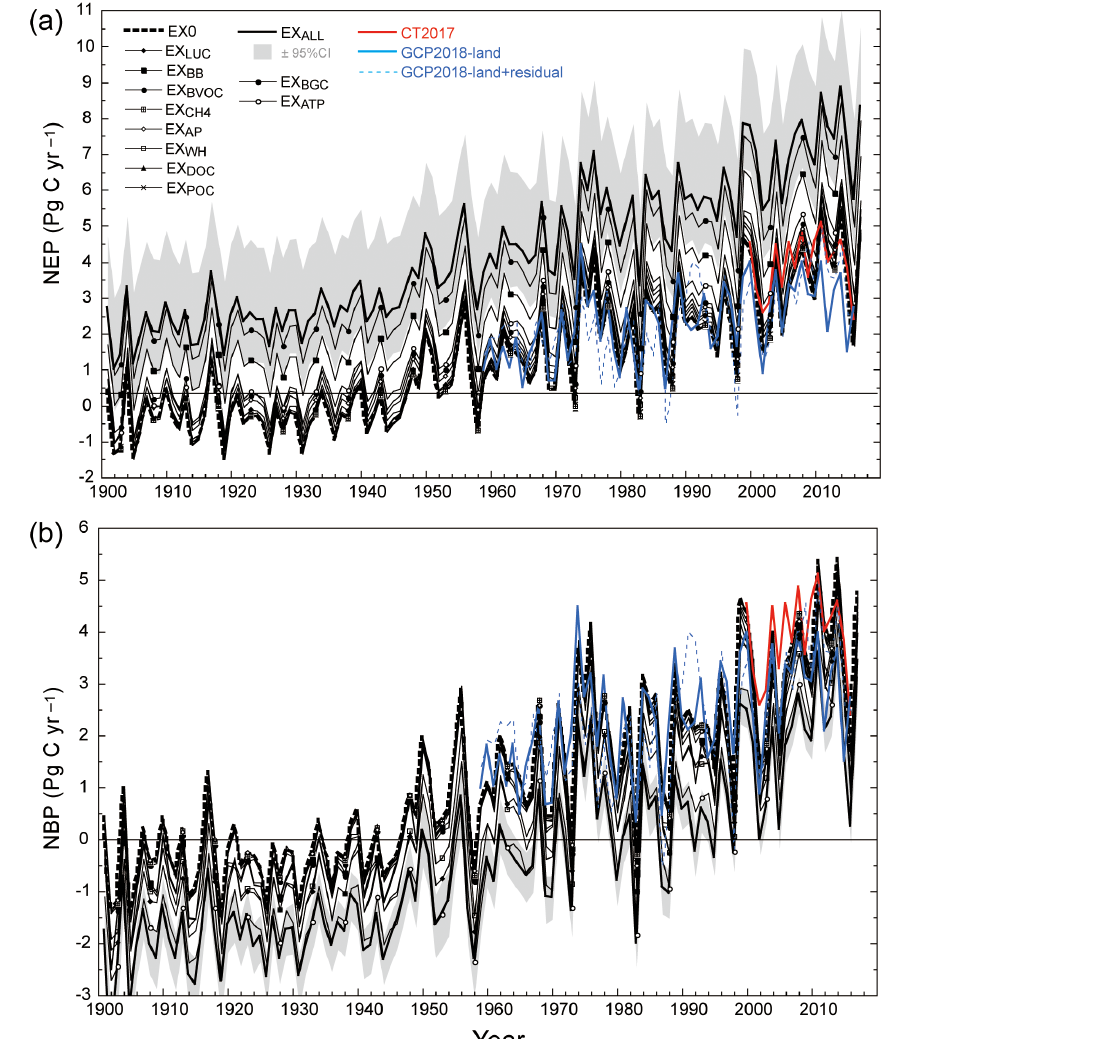
Figure 2. Temporal changes in the simulated global terrestrial carbon budget from this study (black lines), CarbonTracker 2017 (CT2017; Peters et al., 2007; red lines), and the Global Carbon Project (GCP; blue lines). (a) NEP and (b) NBP. See the text for the simulation experiments. Figure S3 presents extracted results for the period